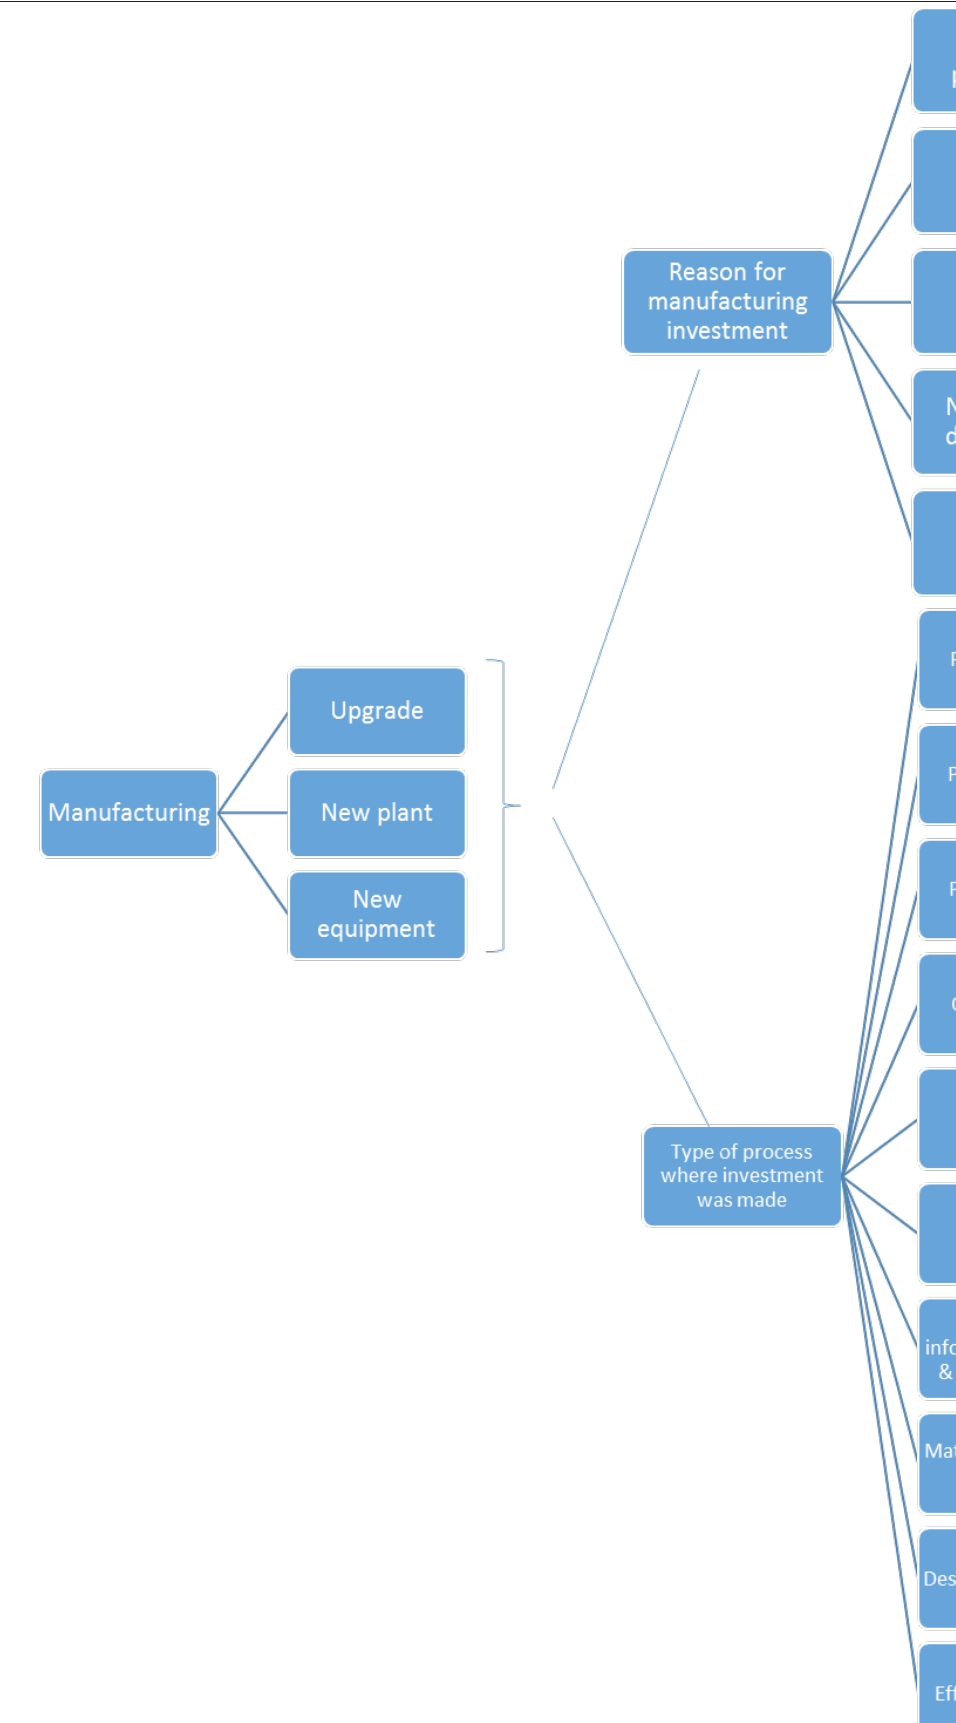
Volume 114 | Number 9/10 September/October 2018